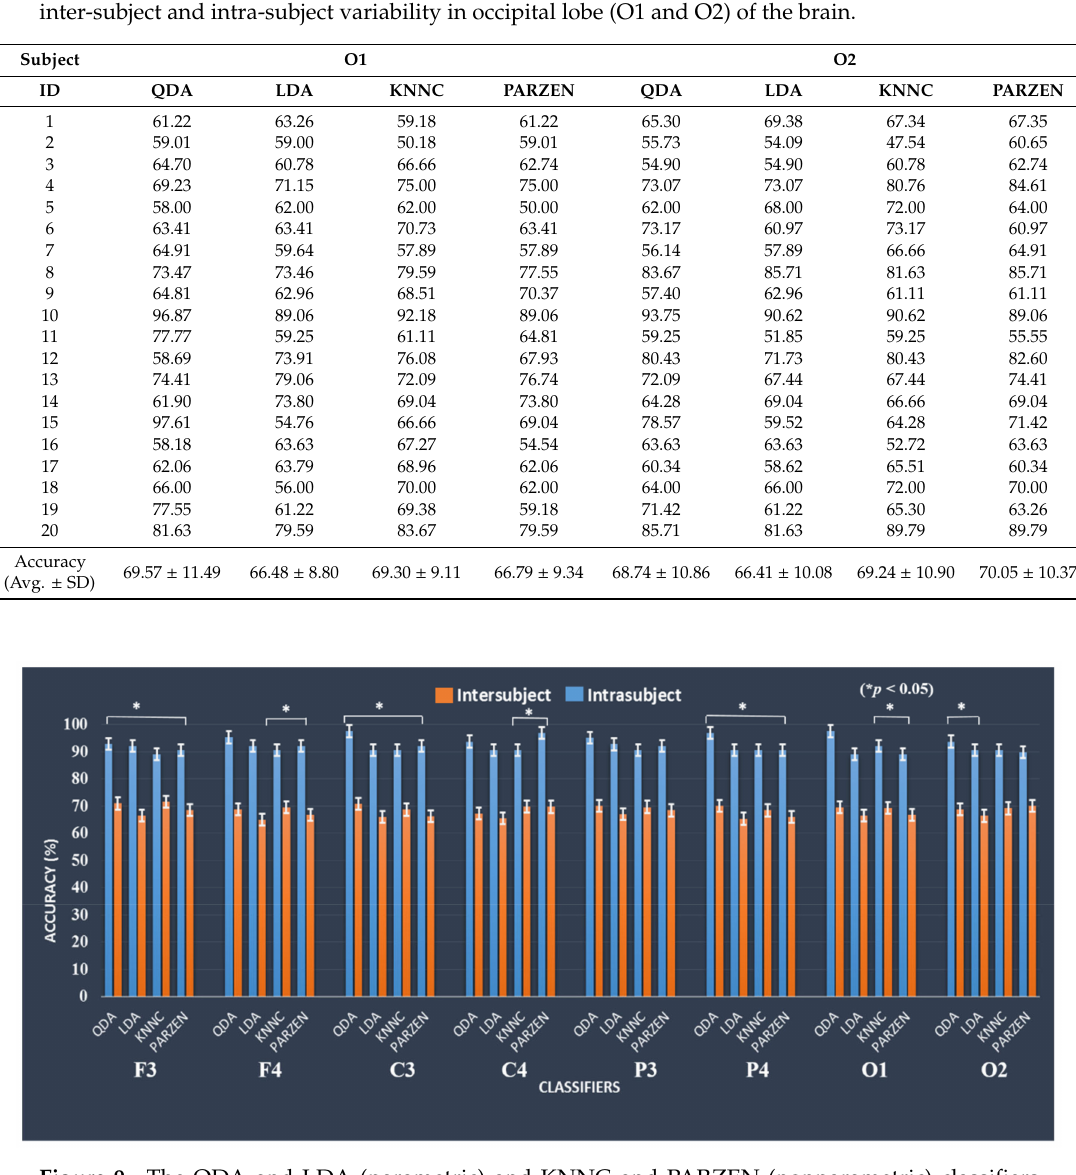
Figure 9. The QDA and LDA (parametric) and KNNC and PARZEN (nonparametric) classifiers performance outcomes comparison in accuracy and standard error bars during inter-subject and intra-subject variability at F3, F4, C3, C4, P3, P4, O1, and O2. Asterisks show pairwise significance di ff erence (* p < 0.05) in t -test between the QDA, LDA, KNNC, and